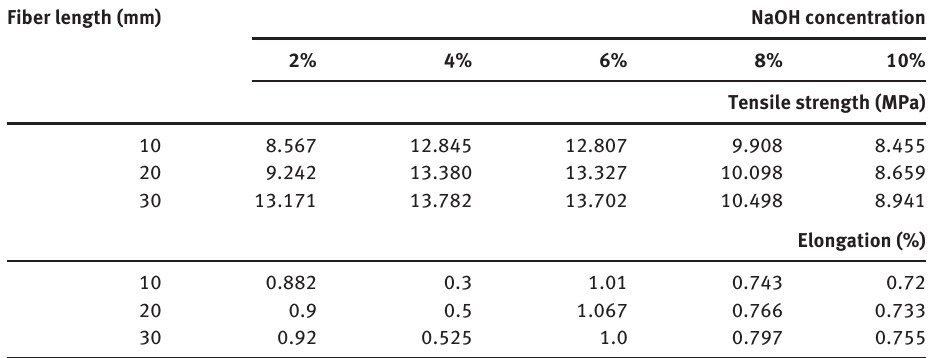
Table 3 Effect of fiber length on tensile strength of NaOH-treated coir fiber-reinforced epoxy